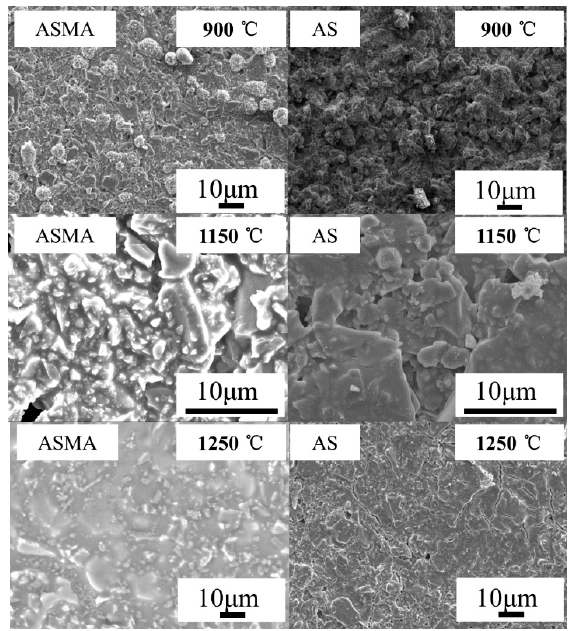
Figure 7. SEM images of outer-surfaces belonging to sample protected by ASMA and sample protected by AS at different temperatures.